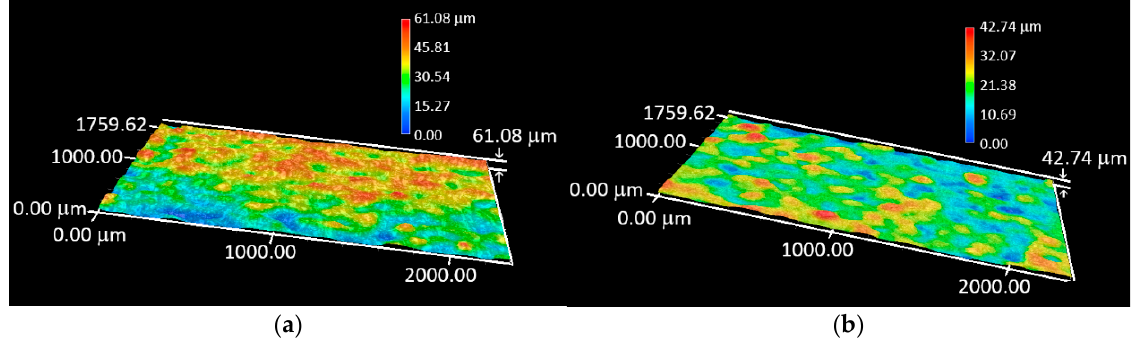
Figure 6. Surface profile of ( a ) Sample 2 and ( b ) Sample 3.